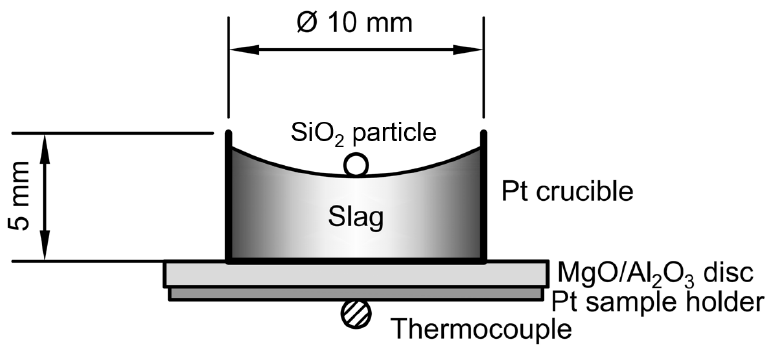
Figure 1. Schematic experimental setup of the dissolution of a synthetic SiO 2 ‘particle in the experi- mental slag by means of HT-CSLM, reproduced from [18], with permission from John Wiley and Sons, 2013. © 2013 The American Ceramic Society.